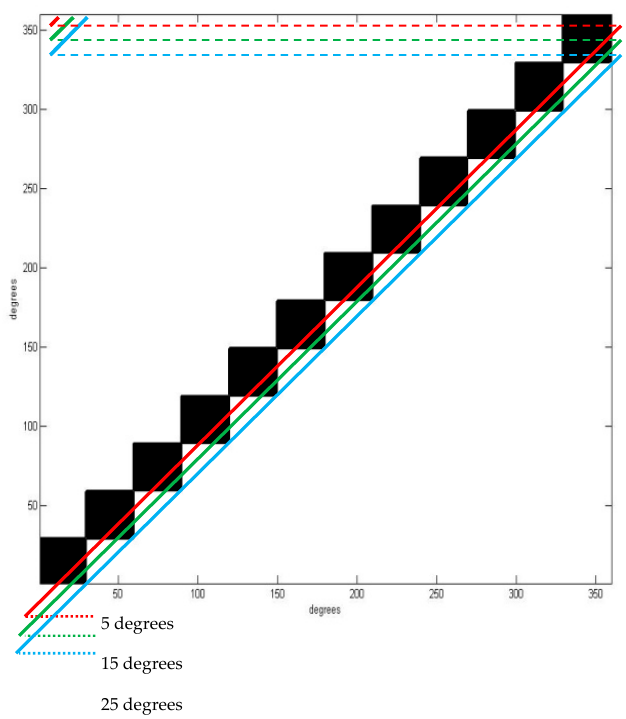
Figure 7. The creation of the membership functions from the “two closest” control areas for 50-to- 50 Hz conversion for switch g 11 and applied phase shifts of 5°, 15°, and 25°.